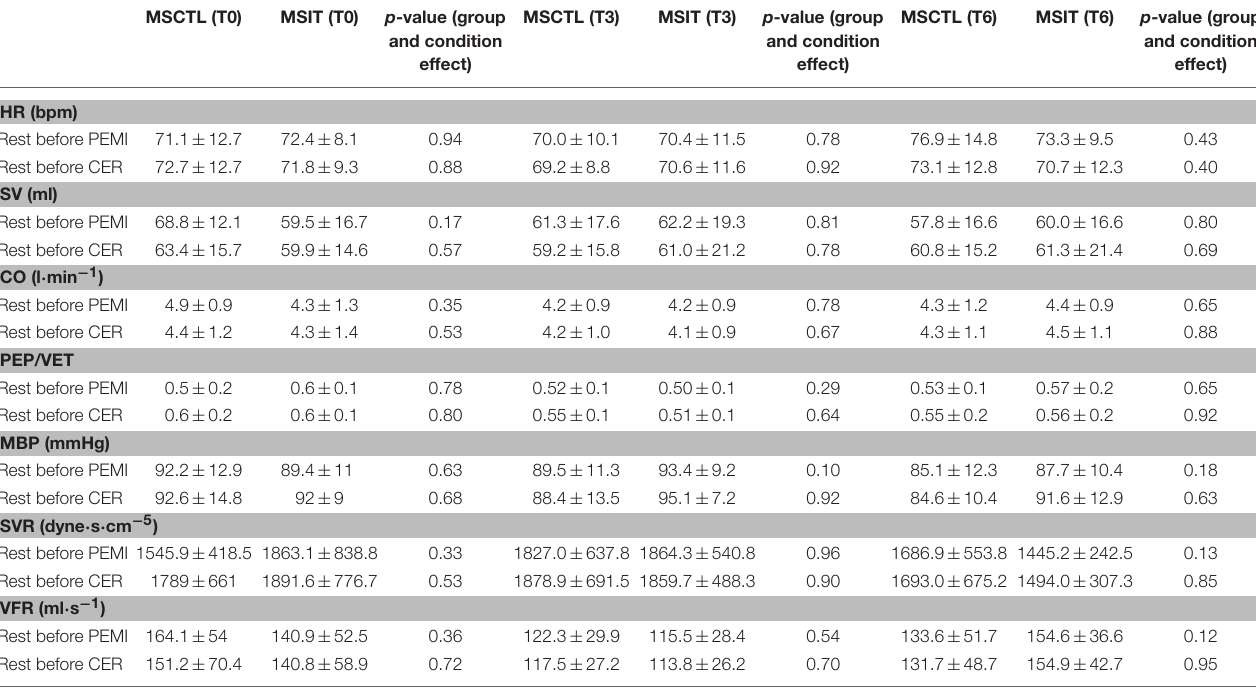
TABLE 2 | Hemodynamic data values during rest periods preceding post-exercise muscle ischemia (PEMI) and control exercise recovery (CER) tests at T0, T3, and T6 in both control Multiple Sclerosis group (MSCTL, n = 10) and in the intervention Multiple Sclerosis group (MSIT, n = 11) group. MSCTL (T0)